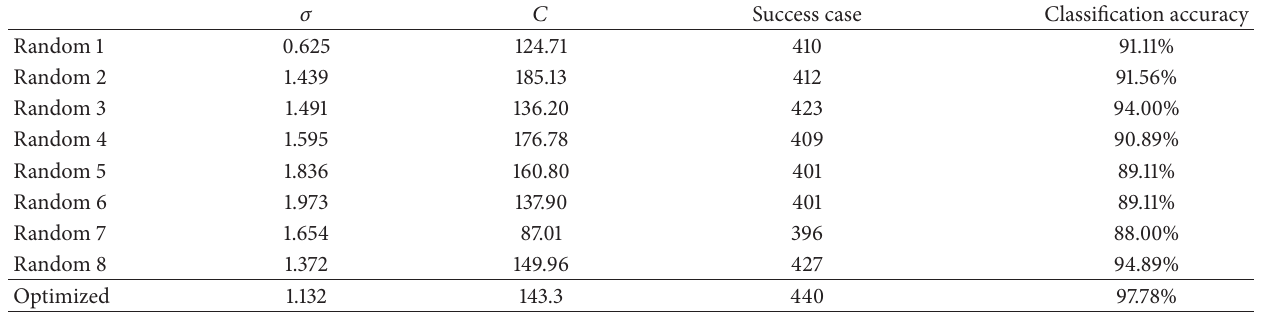
Table 3: Parameters of comparison by random selection method (the final row corresponds to our proposed method).